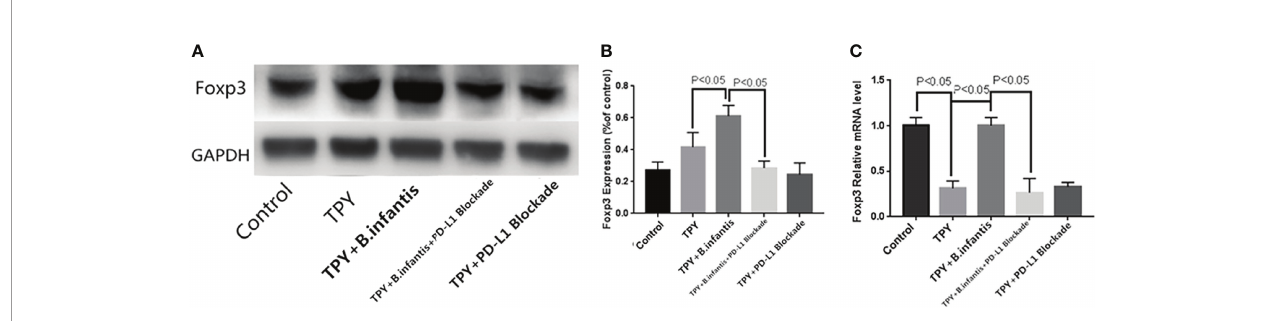
FIGURE 4 | Effect of Bi fi dobacterium infantis supernatant on Foxp3 expression. (A) Foxp3 protein expression band. (B) Differences in Foxp3 protein expression. (C) Differences in Foxp3 mRNA expression. The data in the fi gure are expressed as mean ± standard deviation, and the sample comparison among the groups was conducted using one-way ANOVA. P < 0.05 was considered statistically signi fi cant.